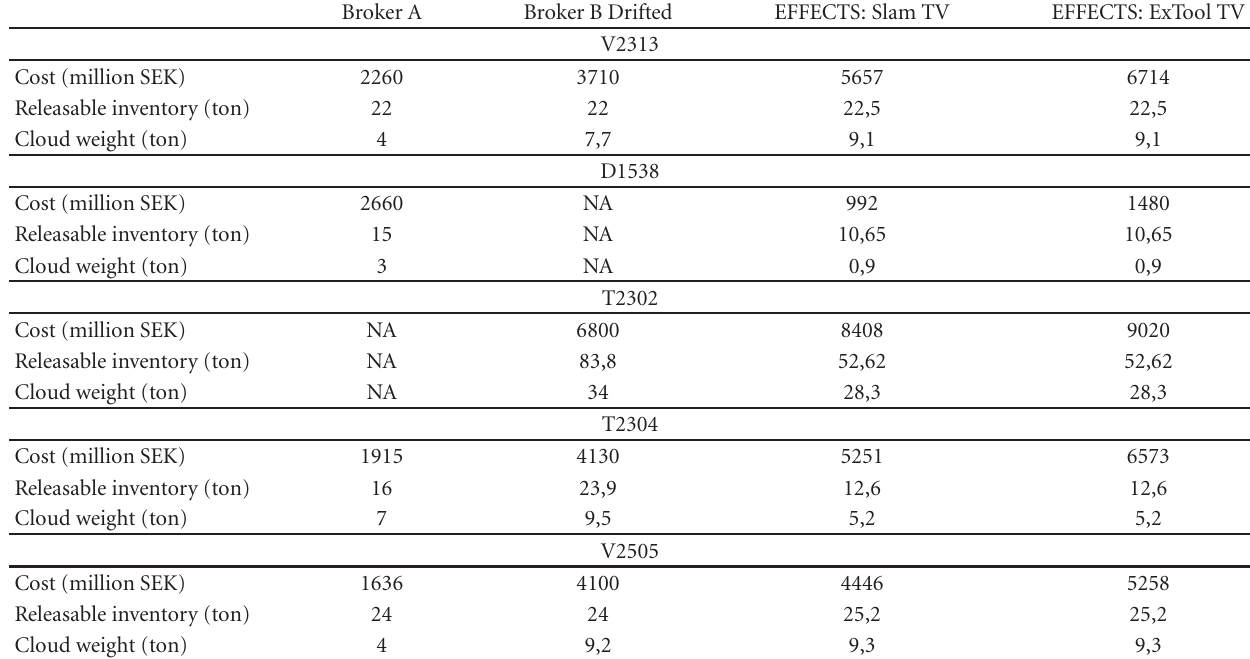
Table 6: A summary of all results from this study.